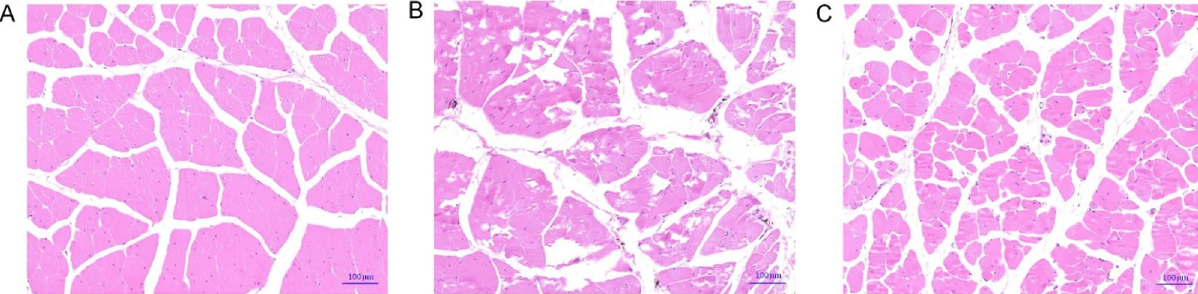
Figure 1. Histopathological observation of Chinese soft-shelled turtles infected with furunculosis pathogens. A was normal control group (NC), B was infection group (Lb18), C was infection treated with NAC group (Lb18 +